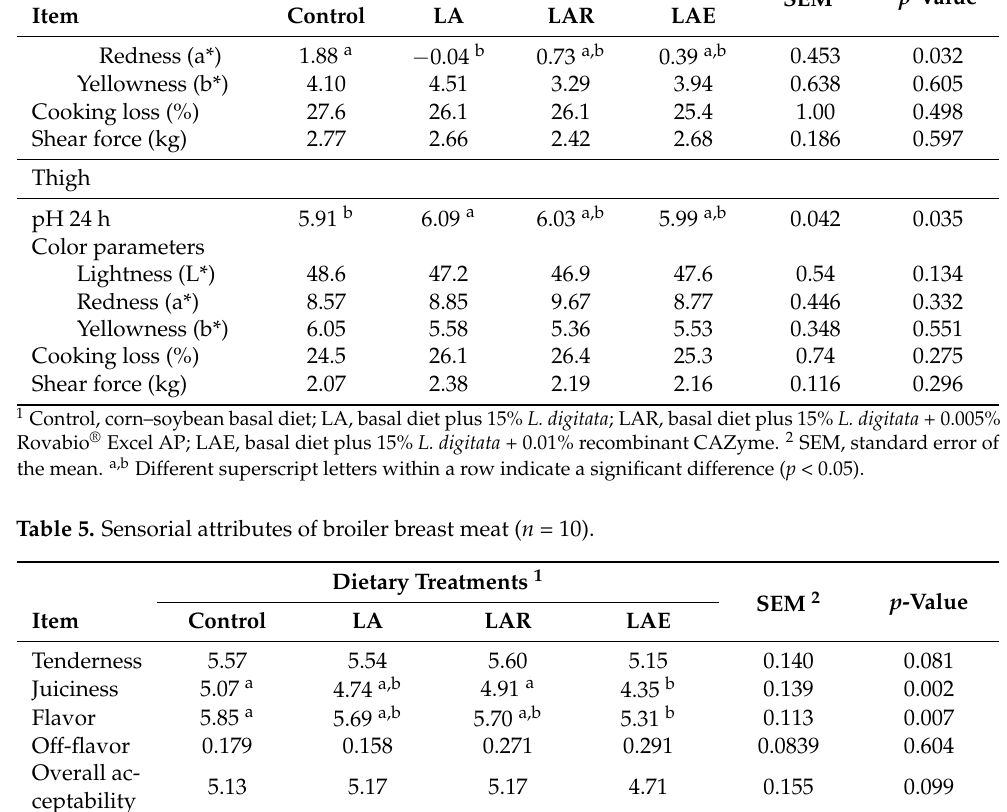
Dietary Treatments 1